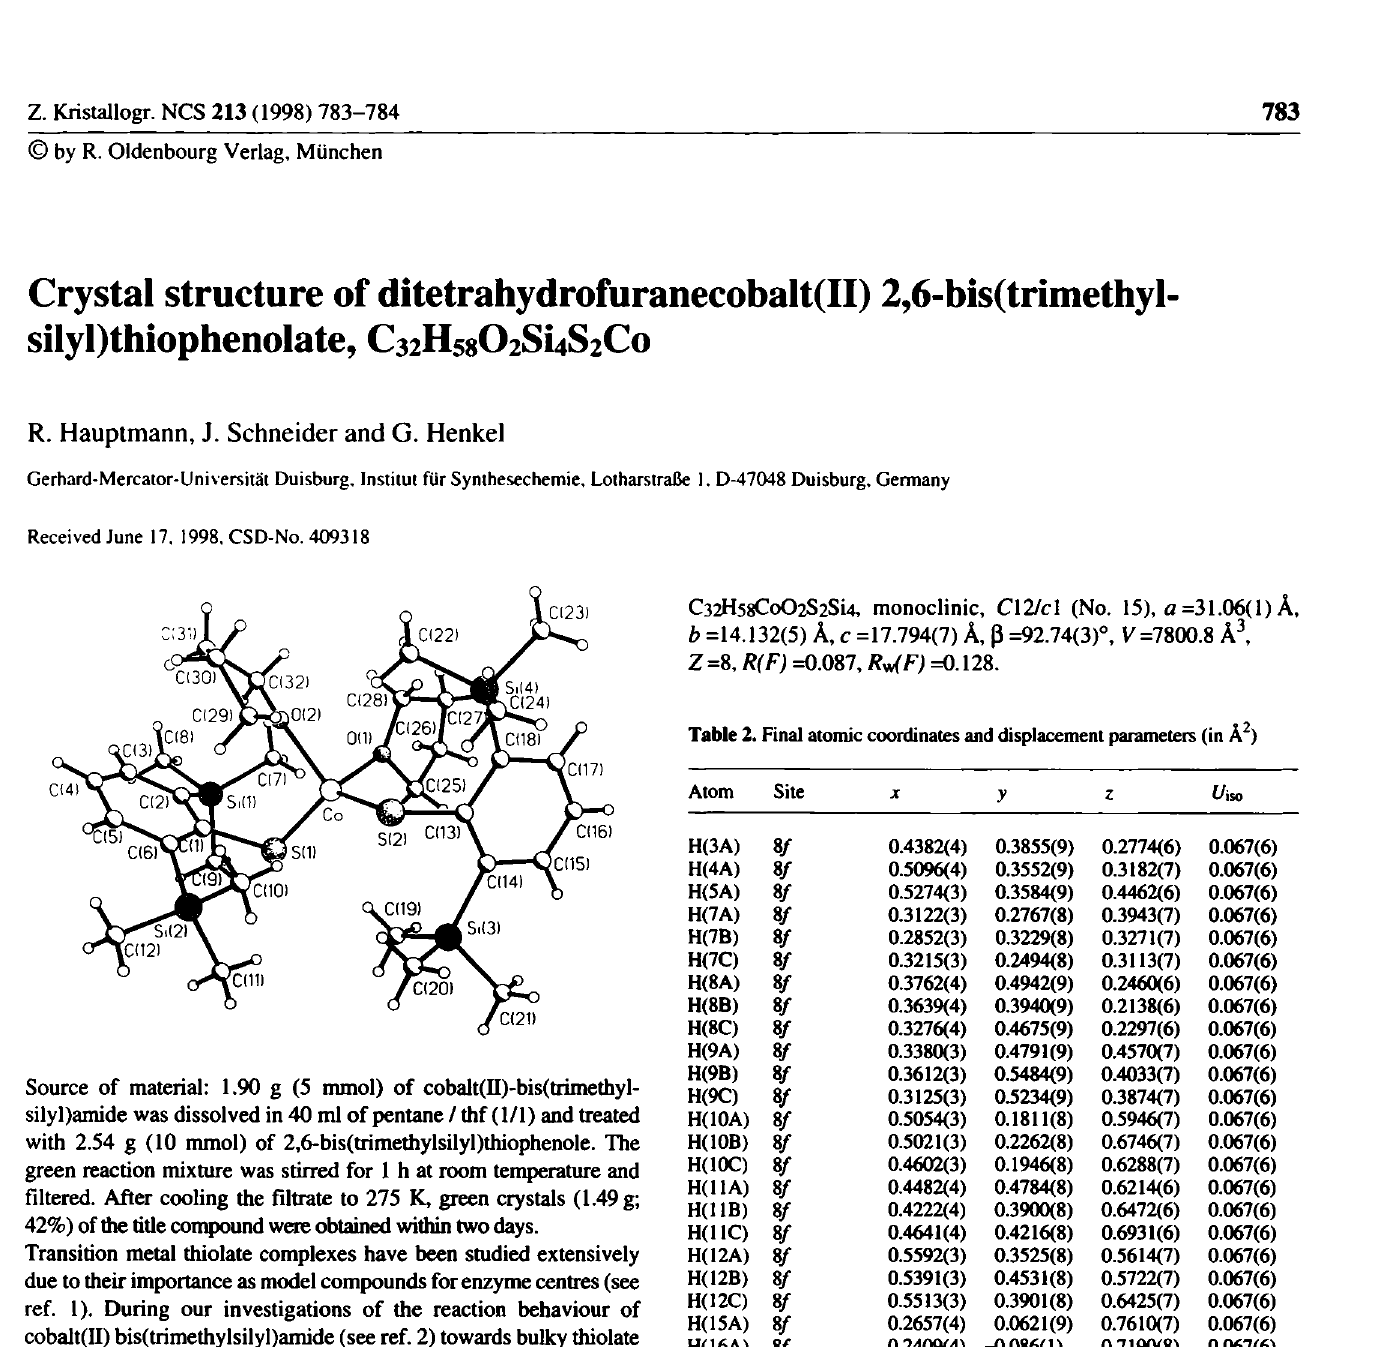
Table 1. Parameters used for the X-ray data collection